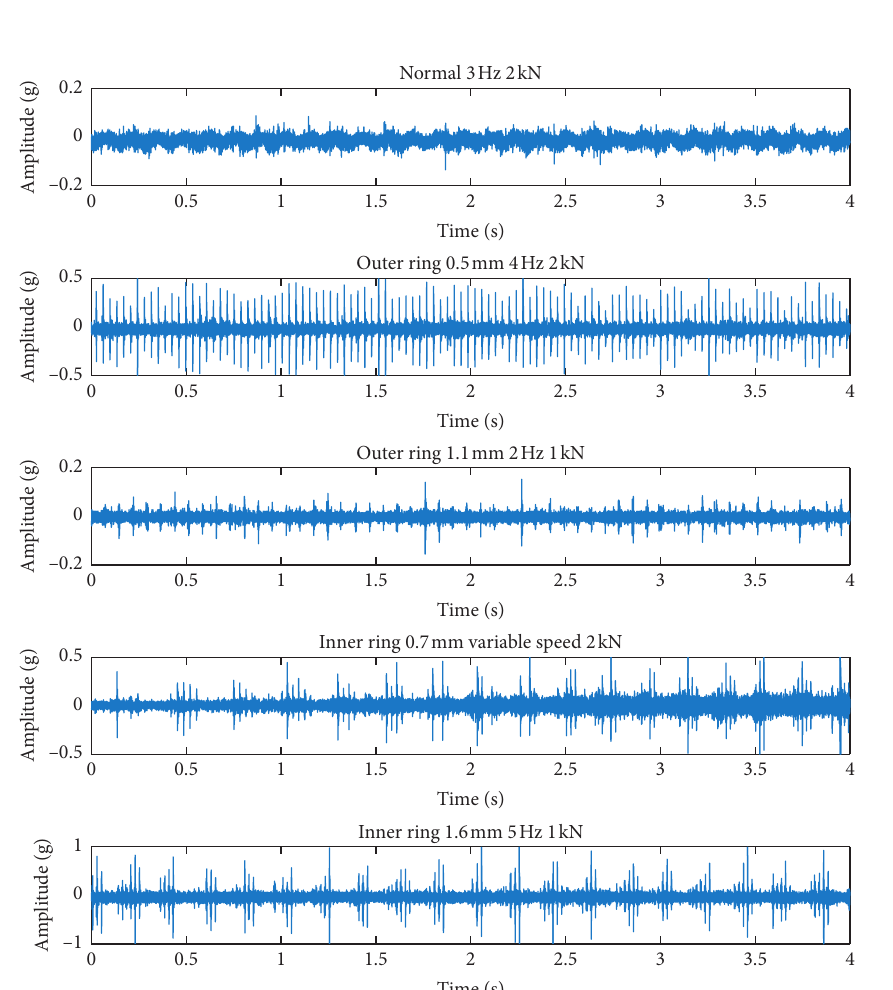
Figure 9: Part of bearing vibration signals with different working conditions and fault